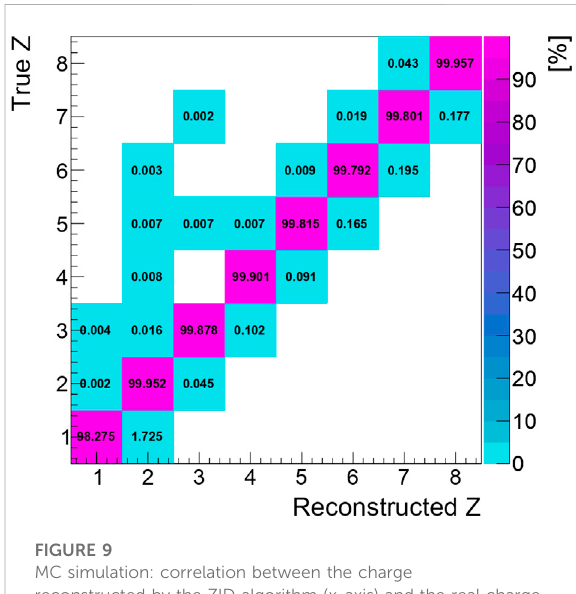
FIGURE 9 MC simulation: correlation between the charge reconstructed by the ZID algorithm ( x -axis) and the real charge extracted from the Monte Carlo truth ( y -axis). For each bin the probability toreconstructthecharge Zfor agivenrealcharge from MC truth is